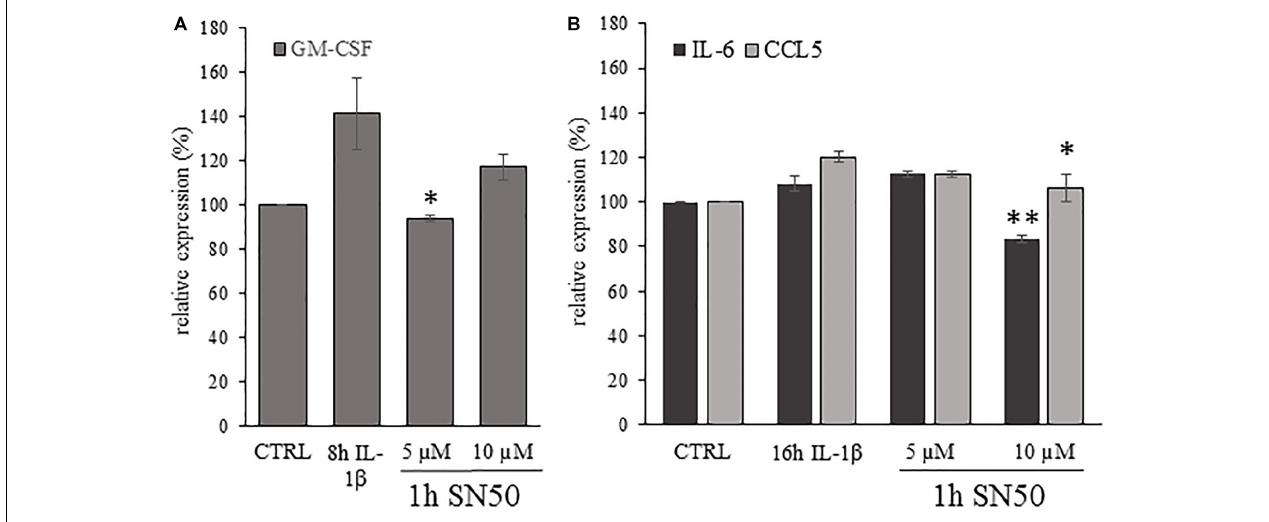
FIGURE 10 | Astrocytic cytokine expression was significantly reduced by SN50, inhibitor of NF- κ B nuclear translocation. (A) Histogram shows relative GM-CSF levels determined by ELISA method after 1 h of pre-treatment by SN50 and 8 h of IL-1 β stimulation. The GM-CSF secretion of the astrocyte cultures is significantly down regulated by 5 µ M SN50 if compared with the IL-1 β -treated cultures. (B) Histogram shows relative IL-6 and CCL5 levels in the supernatant of the astrocyte cultures measured by ELISA method after 1 h of SN50 pre-treatment and 16 h of IL-1 β stimulation. Both cytokine levels show significant reduction due to 10 µ M SN50 treatment if compared with the IL-1 β -treated cultures. Data are shown as mean ± SEM of two independent experiments in duplicate. One-way ANOVA, followed by Student-Newman-Keuls pairwise comparison, ∗ p < 0.05; ∗∗ p <